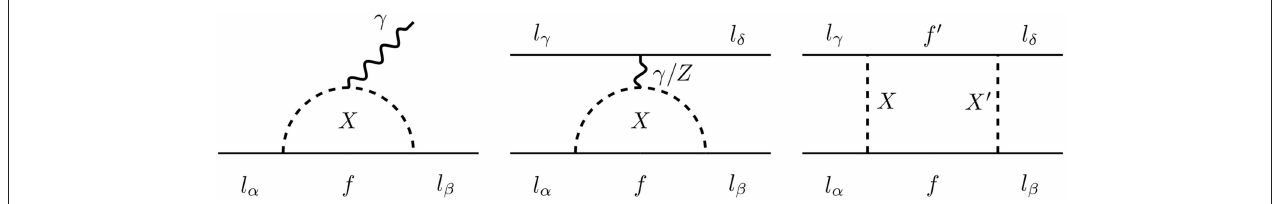
l − β γ (left) and l − α